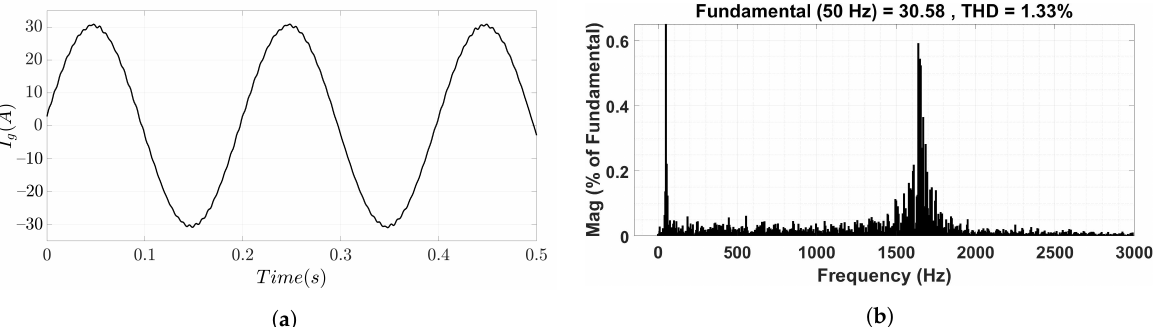
Figure 16. Simulation results of four identical parallel VSIs connected to the grid. ( a ) Grid current waveform. ( b ) Harmonic spectrum of grid